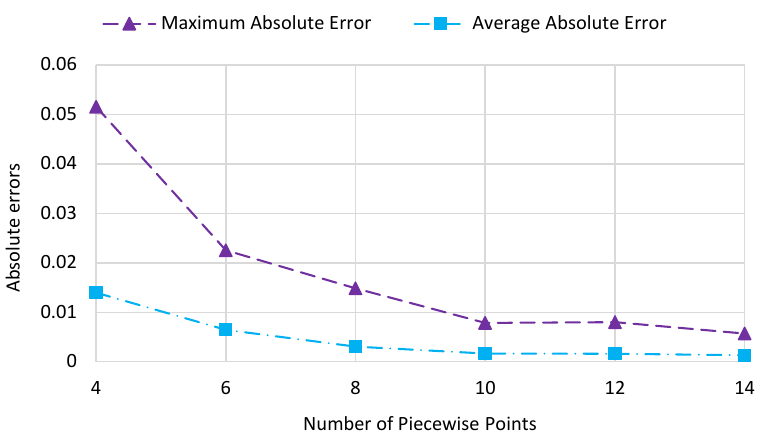
Figure 2. Absolute errors between the piecewise linear fitting function and original function with different numbers of piecewise points based on analysis of curvature values.